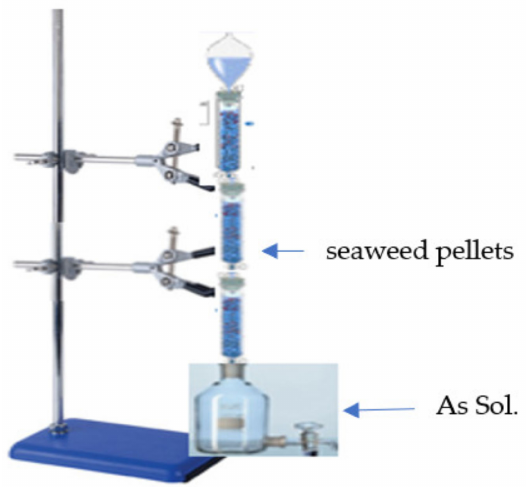
Figure 1. Scheme of the biosorption